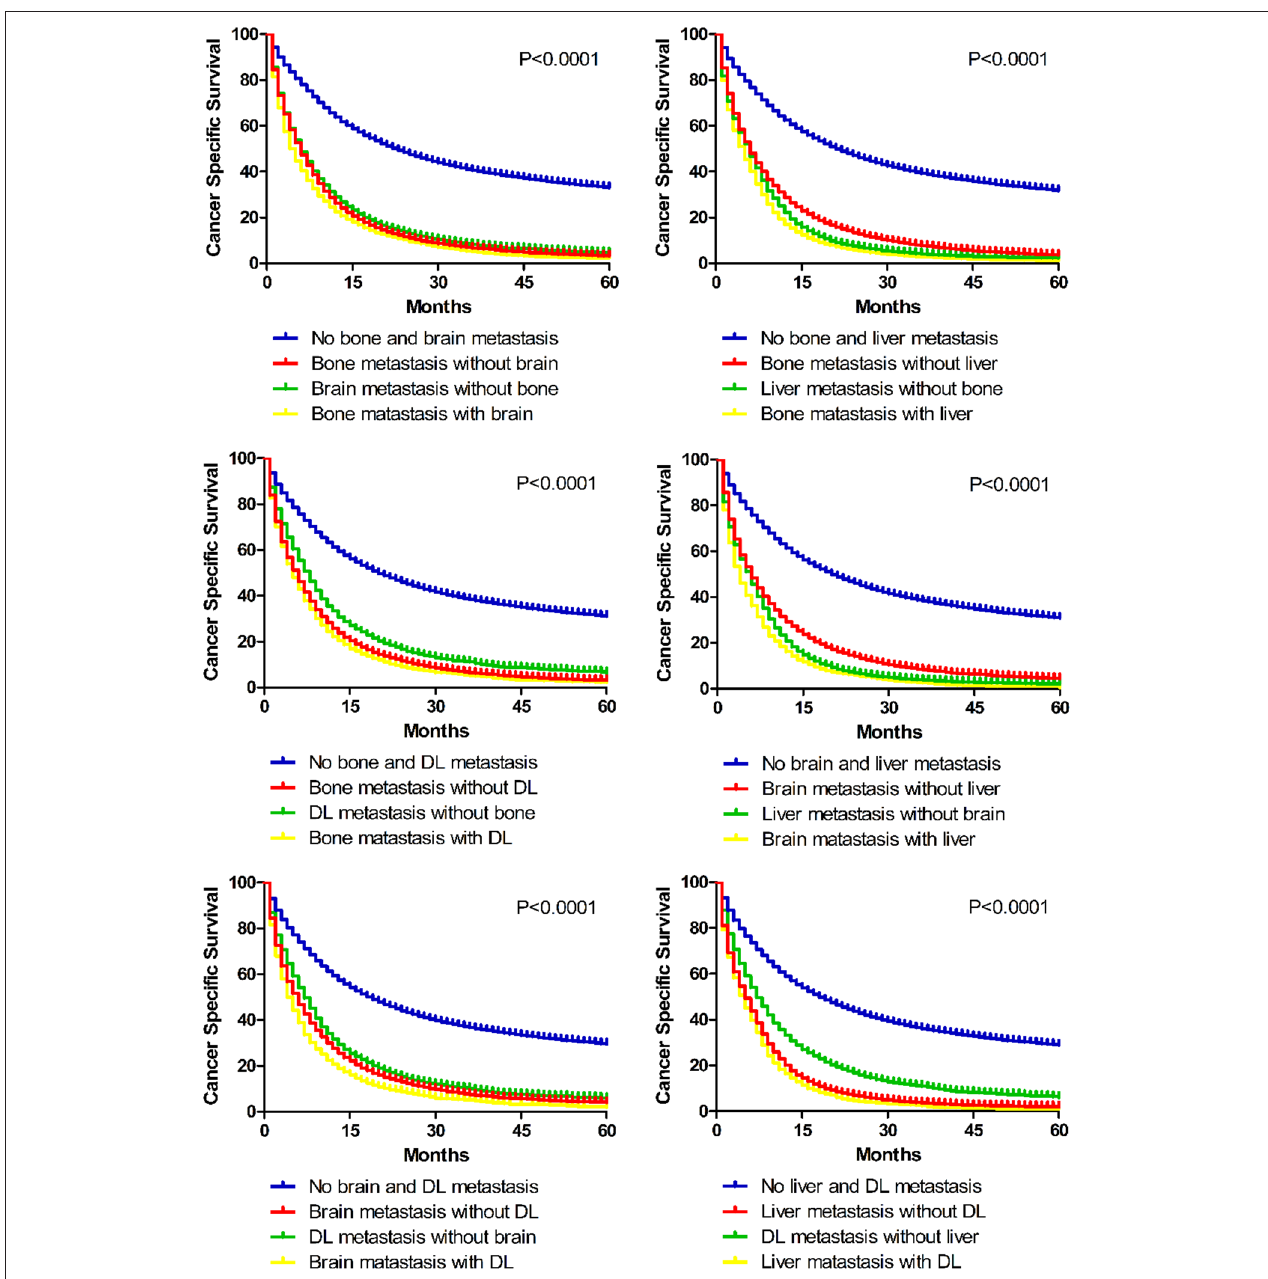
FIGURE 6 | Kaplan–Meier curves of cancer specific survival in patients with different bi-site metastatic patterns.